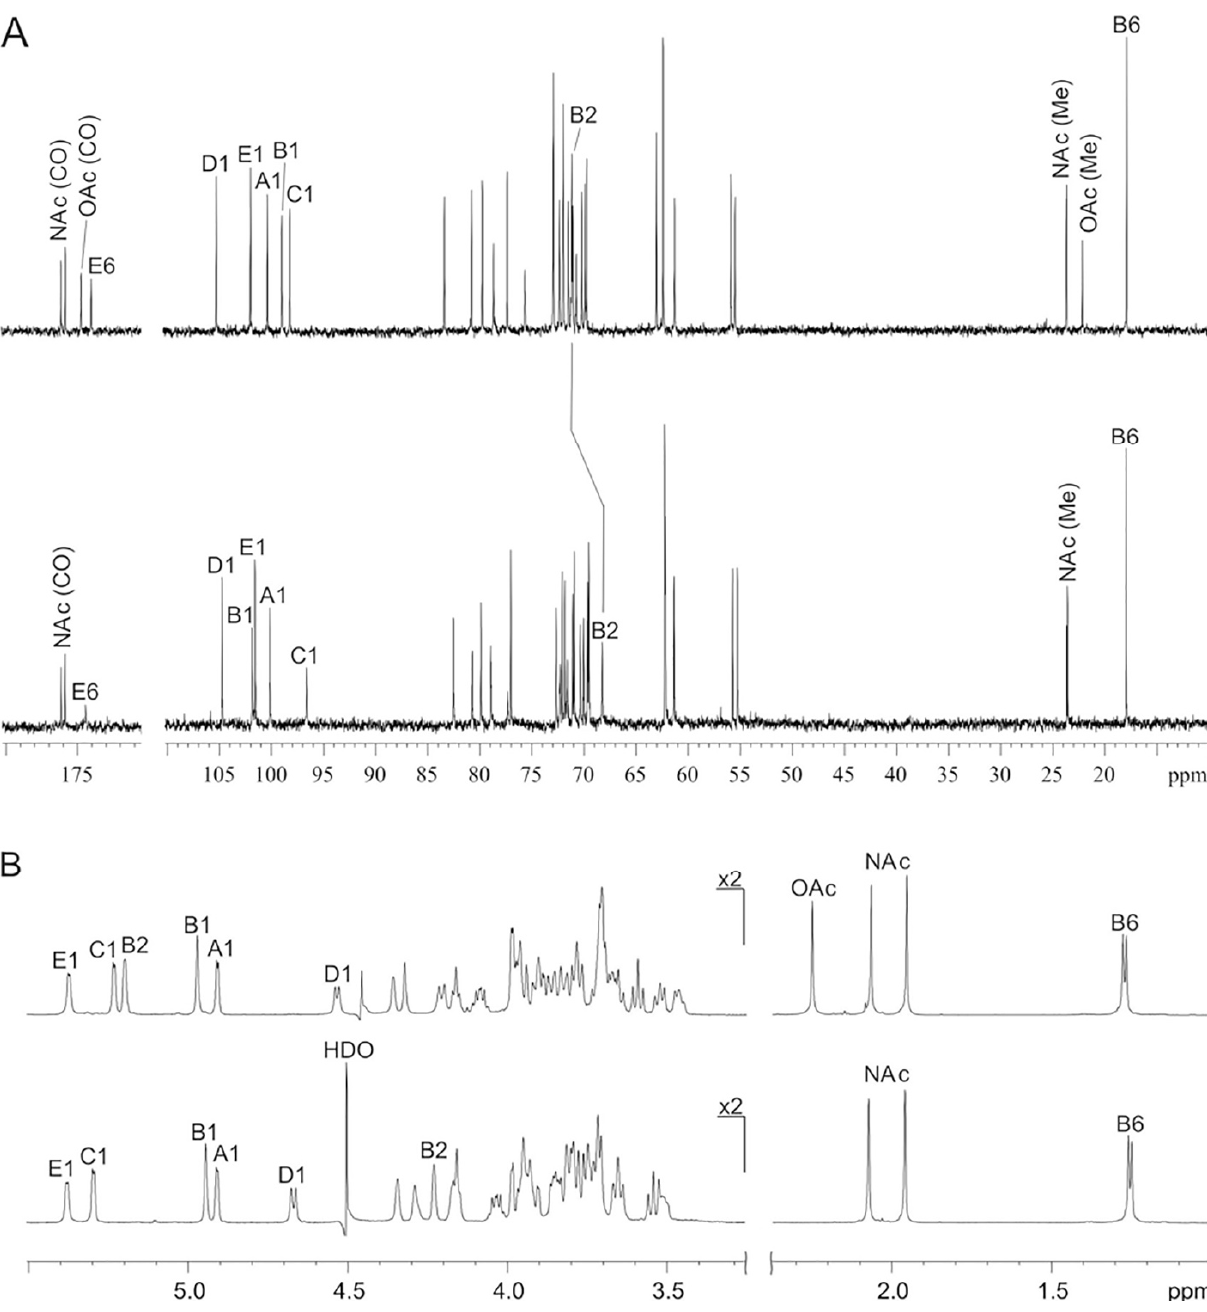
Figure 5. 13C NMR ( A ) and 1H NMR ( B ) spectra of the O-specific polysaccharide ( top ) and modified (O-deacetylated) polysaccharide ( bottom ) from P. versatile F131. (O-deacetylated) polysaccharide ( bottom ) from P. versatile